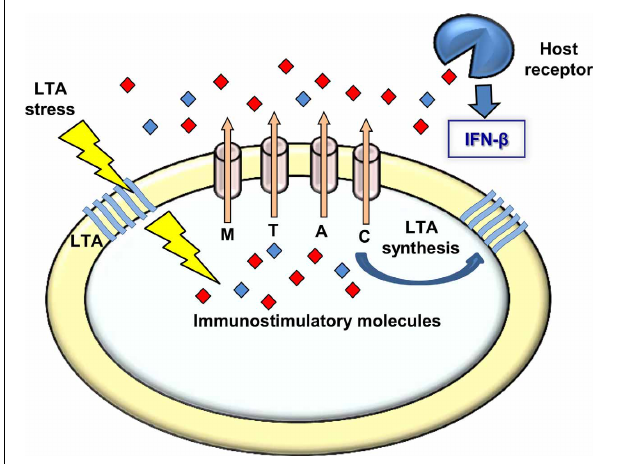
FIGURE 6 | A model linking MDRs, LTA, and induction of type I interferon response. Upon LTA stress L. monocytogenes bacteria secret immuno-stimulatory molecules via the MDR transporters. These molecules are recognized by receptors of the innate immune system leading to type I interferon response. Under normal growth conditions the MDR transporters are involved in LTA synthesis, possibly via secretion of the same immuno-stimulatory molecules that might serve the bacteria as second messenger regulatory molecules regulating LTA synthesis.